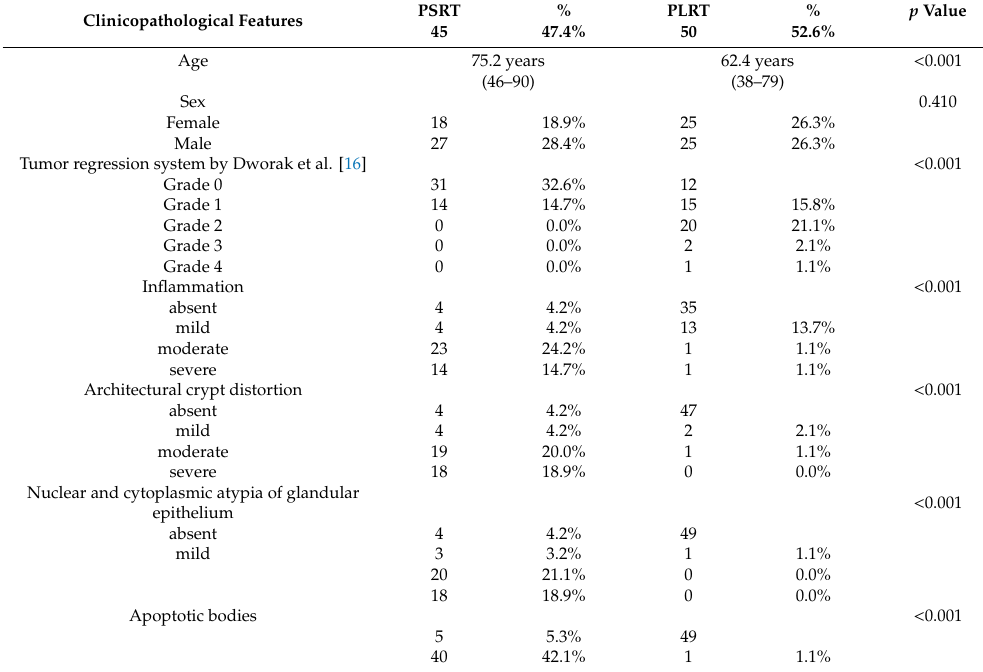
Table 1. Clinicopathological features of preoperative short-course radiotherapy (PSRT) and preoperative long-course radiotherapy (PLRT)